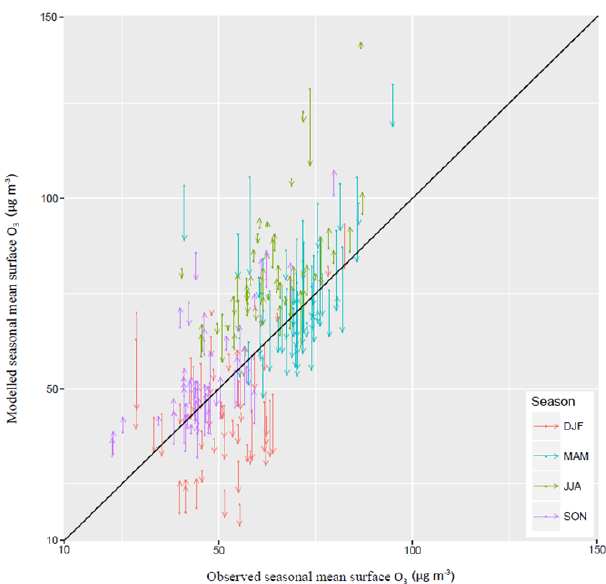
Figure 2. Seasonal mean modelled vs observed O 3 for 52 sites across the EMEP network for the year 2007. The arrow tails mark O 3 concentrations at the coarse resolution while the arrow heads represent the corresponding O 3 concentrations at the finer resolu- tion. The 1:1 line shows agreement between observed and simu- lated O 3